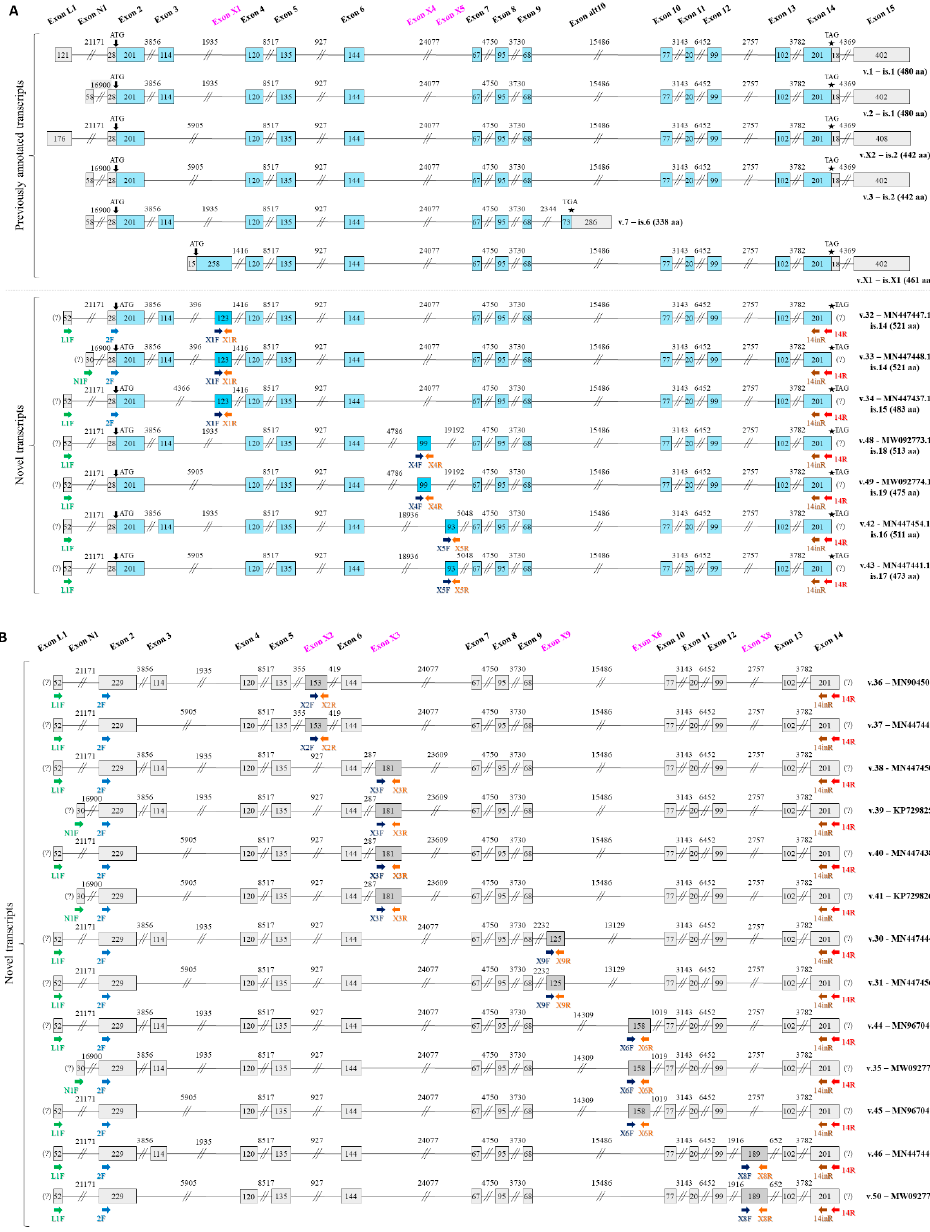
Figure 2. Depiction of the exon structure of the 20 DDC novel transcripts. The names of the novel exons are shown in pink. Exons are presented as boxes and introns as lines, while numbers inside boxes and above lines indicate the length of each exon or intron (in nucleotides), respectively. In the first-round PCR, either of the forward (green color) primers and the common reverse primer (red color) were utilized together. The forward primer (light blue color) in the nested PCR was used along with an exon-specific reverse primer (orange color) for the amplification of the left part of each transcript; the exon-specific forward primer (dark blue color) in the nested PCR was used along with a common reverse primer (brown color) for the amplification of the right part of each transcript. ( A ) Previously annotated DDC transcripts and the 7 DDC novel transcripts with an open reading frame (ORF) are depicted, accompanied by their accession numbers. Blue and grey boxes indicate coding and non-coding exons, respectively, while novel exons are colored with a more intense blue shade. Arrows ( ↓ ) indicate the position of the ATG codon, pentagrams ( (cid:70) ) show the position of the stop codon, and question marks (?) represent an undetermined untranslated region (UTR). ( B ) DDC novel transcripts without an ORF, accompanied by their accession numbers. Novel exons are colored dark